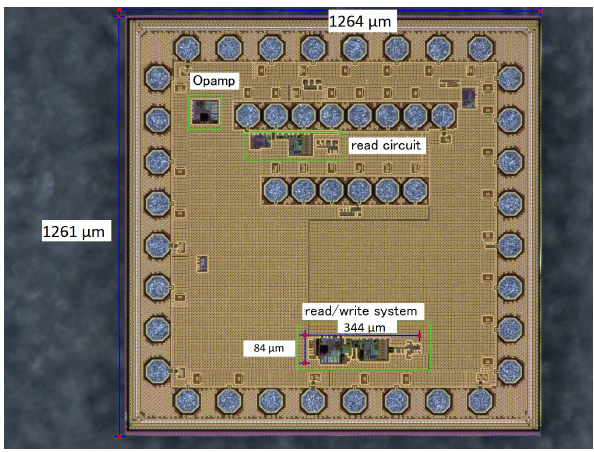
Figure 8. Picture of the integrated